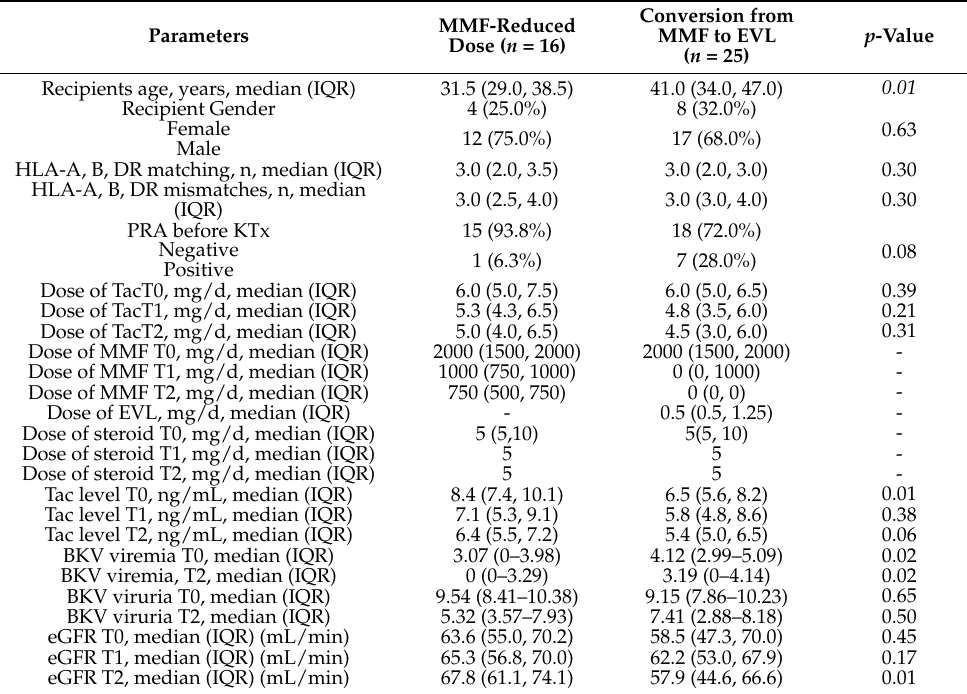
Figure 6. Changes in eGFR during the 6-month follow-up period in 41 KTx patients with BKV infection with p = 0.855 for the whole group ( n = 41), p = 0.695 for the BKV group ( n = 35), and p = 0.884 for the BKVN ( n = 6). Table 5. Outcome of BKV infection after 6-month follow-up according to immunosuppressive